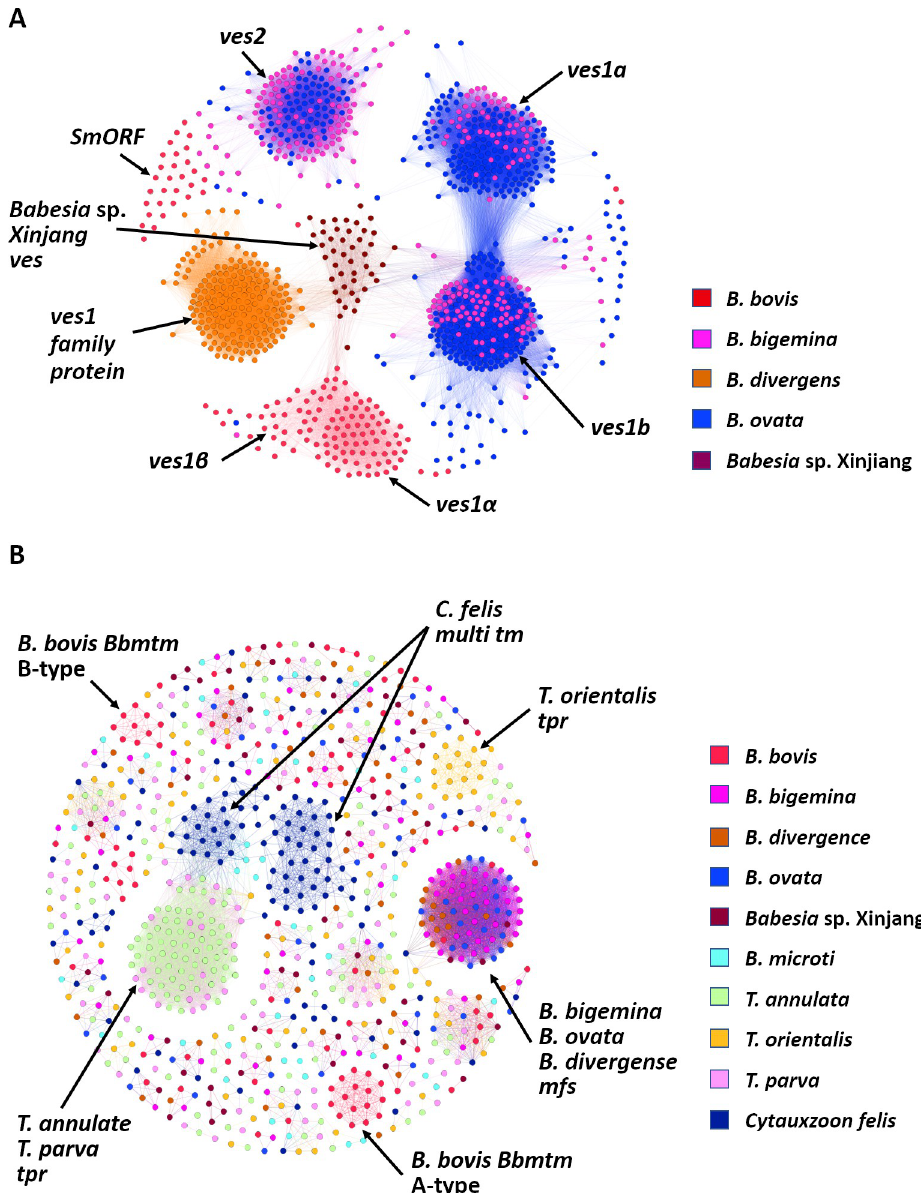
Fig 4. Homology clustering based on sequence similarities of ves and multi-transmembrane protein encoding genes. ( A) ves and smorf genes sequence were extracted from piroplasmaDB (https://piroplasmadb.org/piro/app), and a sequence similarity network was visualized by Gephi. (B) The figure was reproduced from Hakimi and colleagues [33]. The genes encoding proteins with more than 8 TM domains were extracted from piroplasmaDB and clustered. SmORF, Small Open Reading Frame; TM,